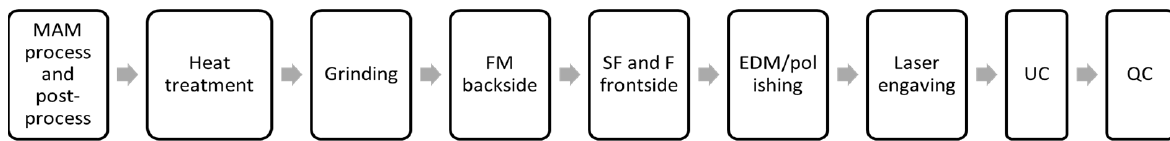
Figure 2. Simplified scheme of the conventional manufacturing process chain. Figure 3. Simplified scheme of the additive manufacturing process Figure 3. Simplified scheme of the additive manufacturing process chain.